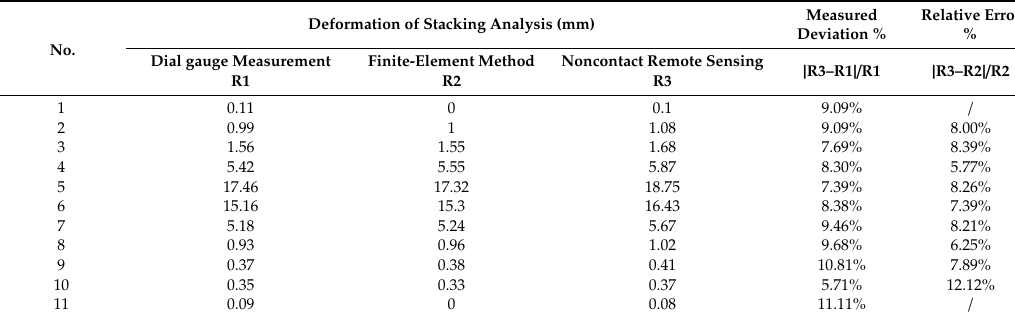
Table 3. Comparison